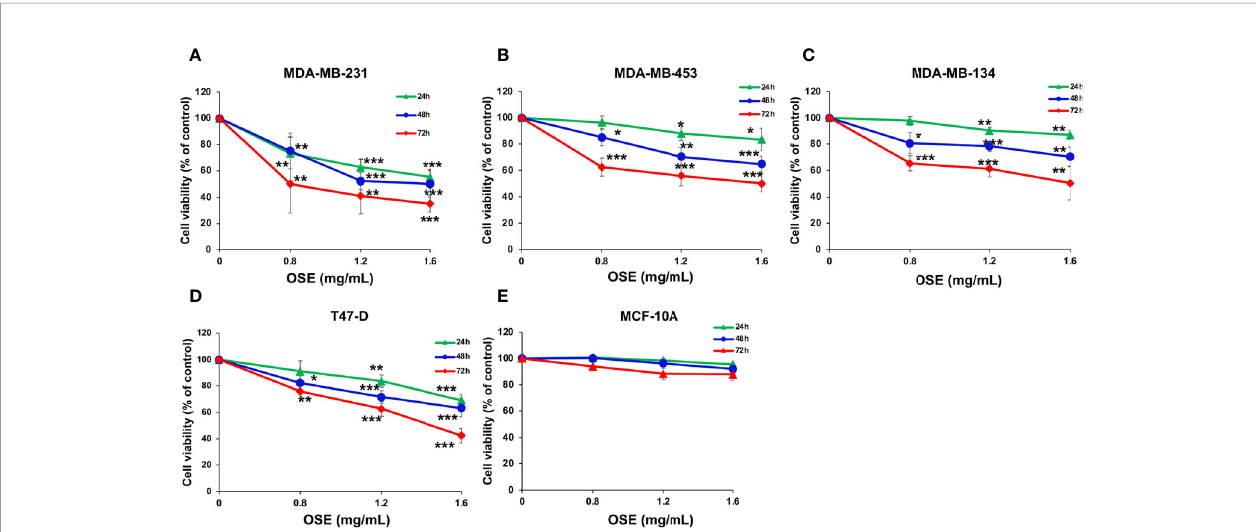
FIGURE 1 | OSE Inhibits proliferation of a battery of breast cancer cell lines (MDA-MB 231 (A) , MDAMB-453 (B) , MDAMB-134 (C) T47-D (D) , without signi fi cantly inducing cytotoxicity in normal human mammary epithelial cells (MCF10A) (E) . Cells were treated with increasing concentrations of OSE (0.8, 1.2 and 1.6 mg/ml) for 24, 48, and 72 h Cell viability was assessed by the overall metabolic activity measured by MTT. Values are calculated as % of the corresponding vehicle control value and represented as mean ± standard error of the mean (SEM) of three independent experiments, each run in triplicate. (*p < 0.05, **p < 0.01 and ***p <